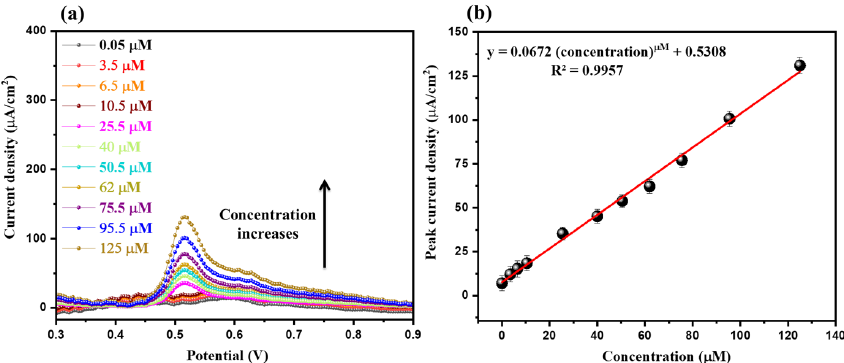
Figure 8. DPV patterns ( a ) of S@rGO/GCE in various concentrations (0.05 µM, 3.5 µM, 6.5 µM, 10.5 µM, 25.5 µM, 40 µM, 50.5 µM, 62 µM, 75.5 µM, 95.5 µM, and 125 µM) of acetaminophen in 0.1 M PBS of pH 7.0 at a scan rate of 50 mV/s. ( b ) Calibration curve between peak current density response versus acetaminophen concentration.